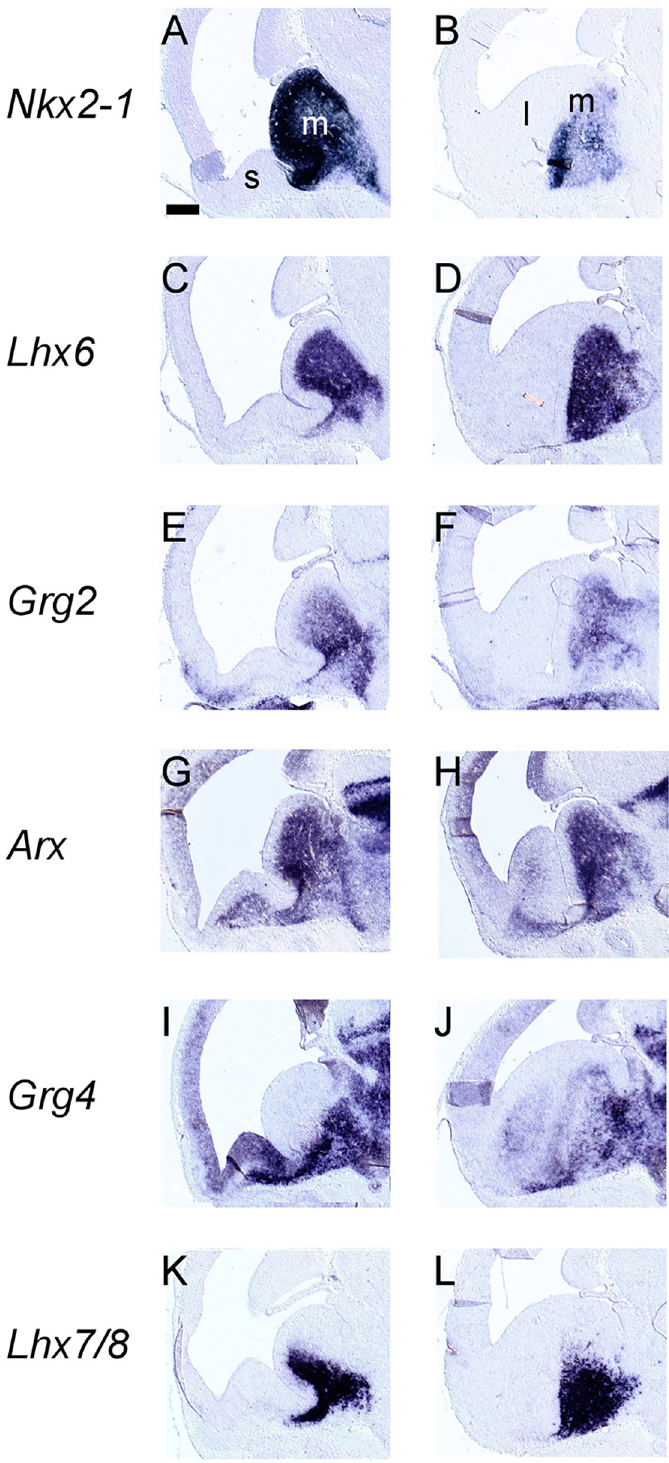
Fig 9. In situ hybridization on adjacent sagittal sections through the embryonic telencephalon from lateral (left) to medial (right) levels hybridized with an antisense RNA probe of Nkx2 . 1 (A, B), Lhx6 (C, D), Grg2 (E,F) and Arx (G, H), Grg4 (I,J) and Lhx7/8 (K,L) m: MGE, l: LGE, l: LGE, s: septum. Scale: 250 μ m.